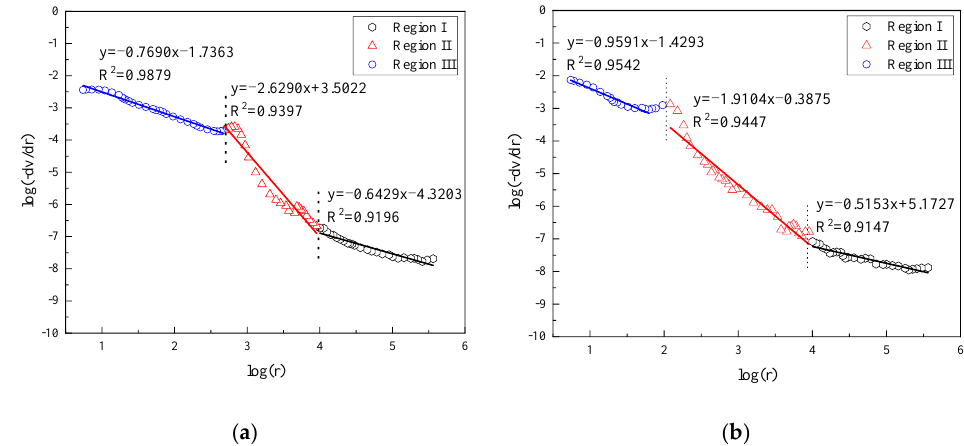
Figure 16. Multifractal characteristics of FCP30 at different ages under Pfeifer and Avnir’s model. ( a ) 3 days, ( b ) 28 days.